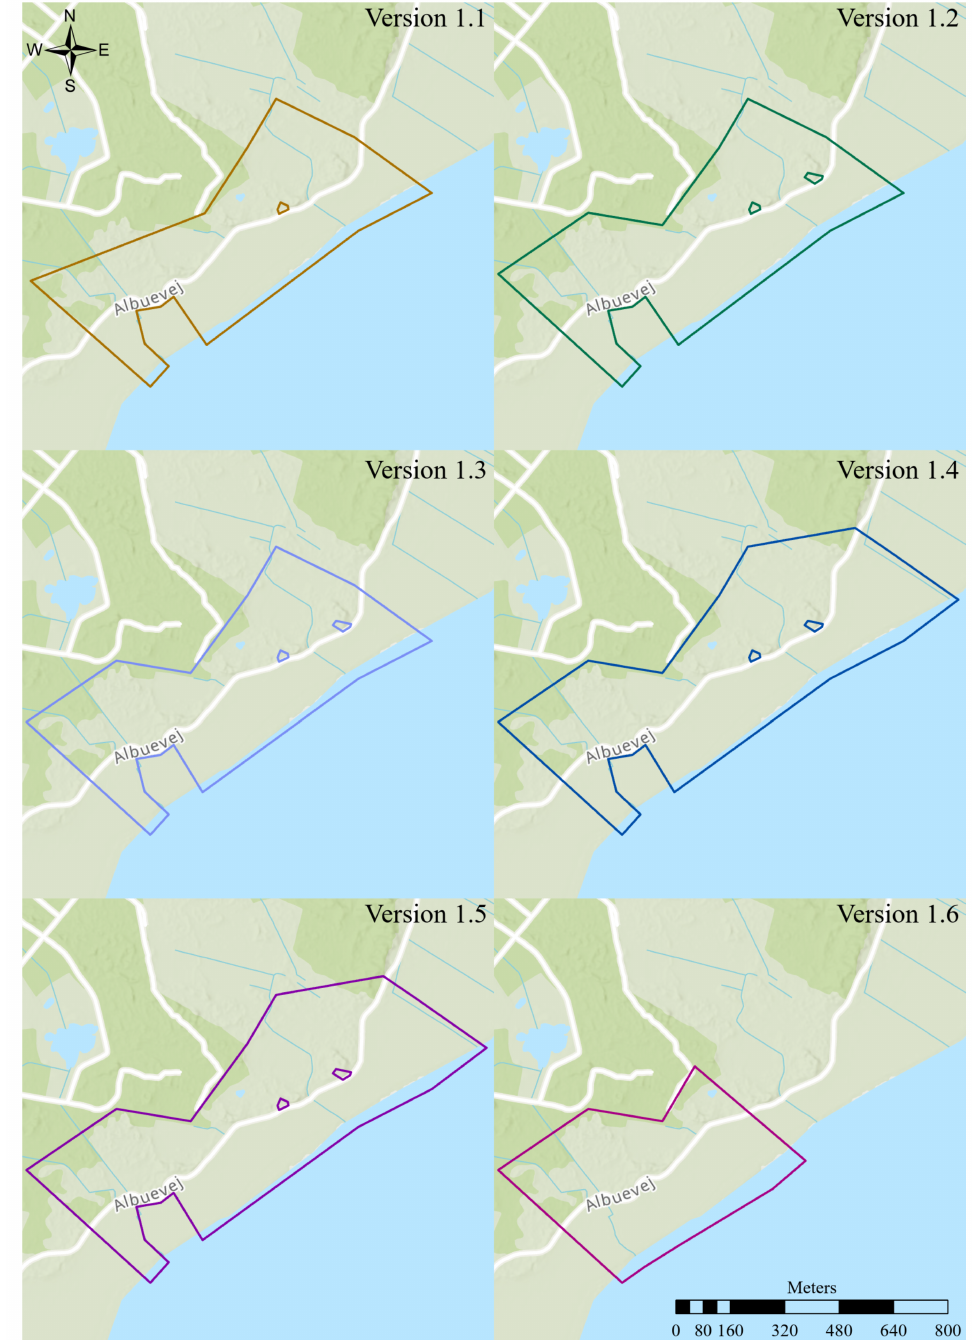
Figure A3. The virtual enclosure during period 1 . The coordinates of the lower right corner of each map frame are 8 ◦ 27 (cid:48) 59 (cid:48)(cid:48) E 55 ◦ 23 (cid:48) 46 (cid:48)(cid:48)